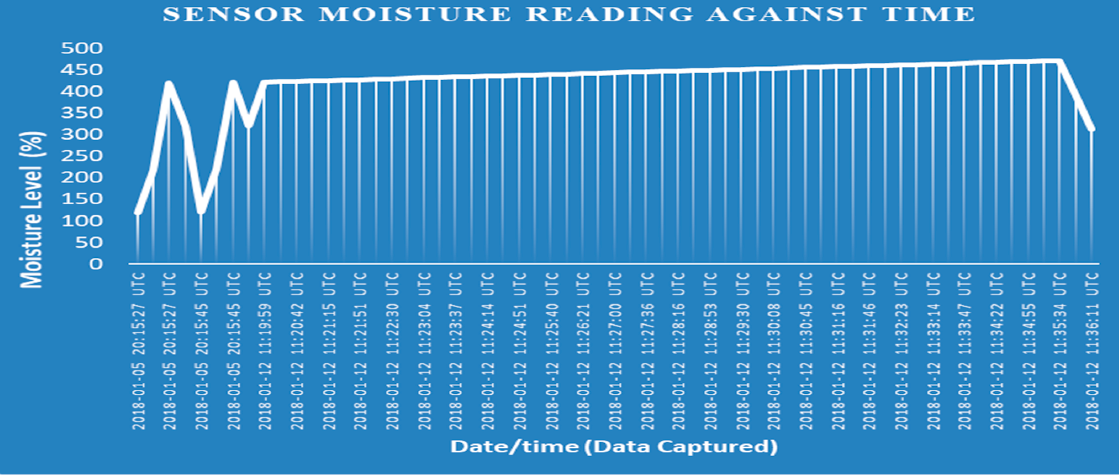
Figure 19. Soil moisture values against time.